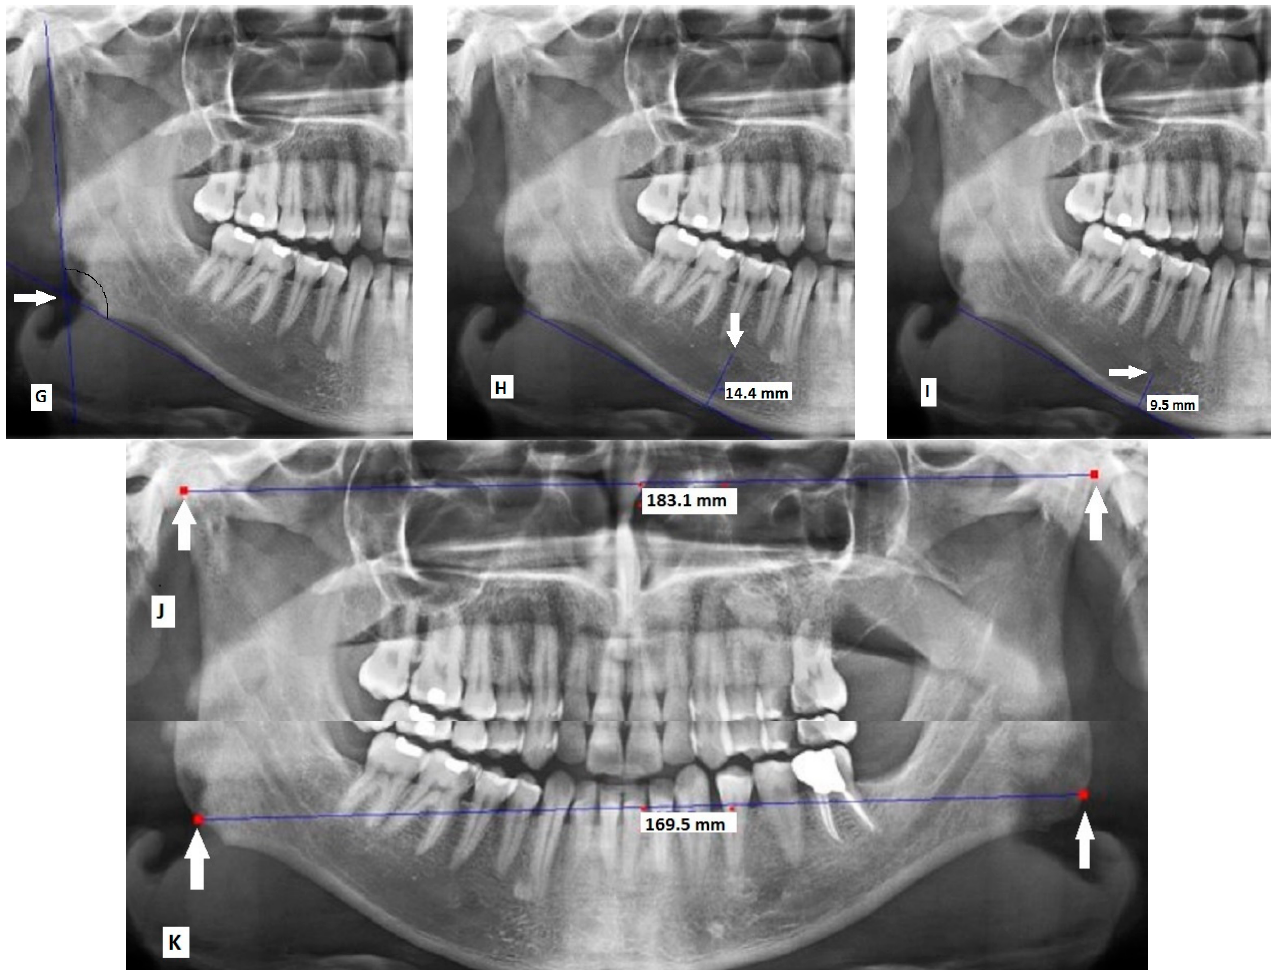
Figure 1. Measurements made on panoramic radiographs: ( A ) maximum ramus width; ( B ) minimum ramus width; ( C ) condylar height; ( D ) coronoid height; ( E ) antegonial angle; ( F ) antegonial depth; ( G ) gonial angle; ( H ) distance between the superior border of the mental foreman and the inferior border of the ramus; ( I ) distance between the inferior border of the mental foramen and the inferior border of the ramus; ( J ) bicondylar breadth; and ( K ) bigonial breadth.